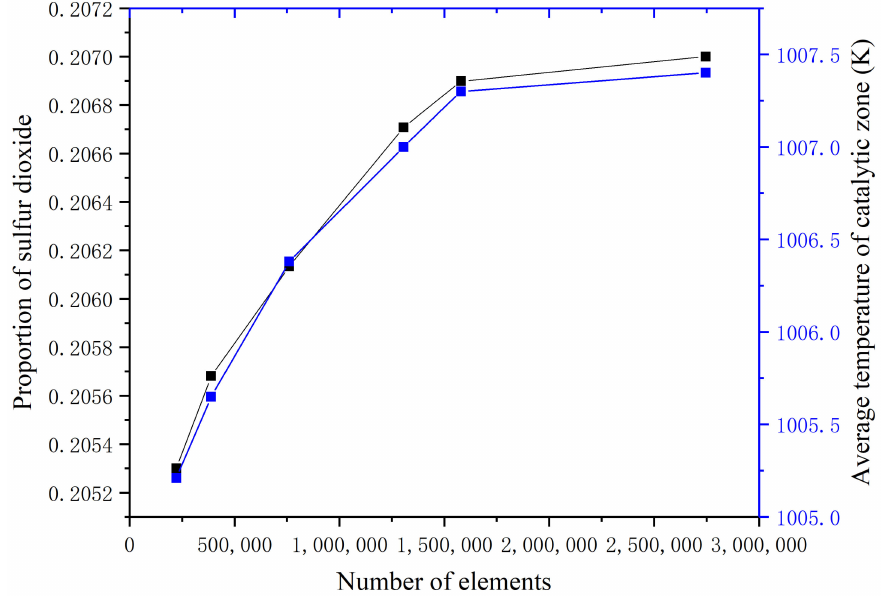
Figure 4. Grid independence